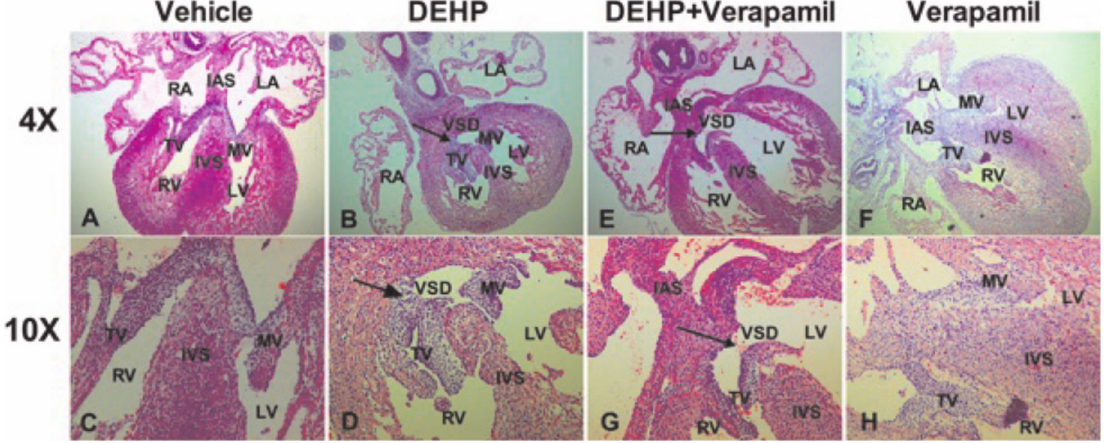
Fig 2. Fetal cardiac malformations induced by maternal Di-(2-ethylhexyl)-phthalate (DEHP) and verapamil exposure from E6.5 to E14.5. The phenotypes of fetal cardiac malformations included septal defects (B, D, E, G). The magnification used was 4 × and 10 ×